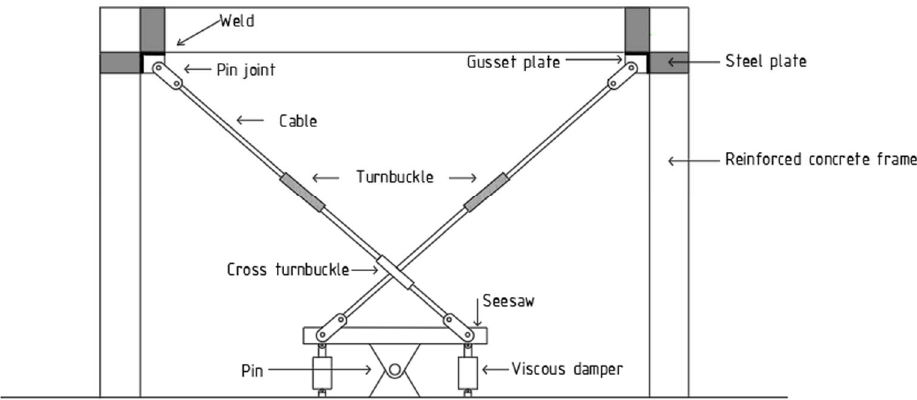
Figure 1. Installation and connection details of a seesaw system within an RC frame.